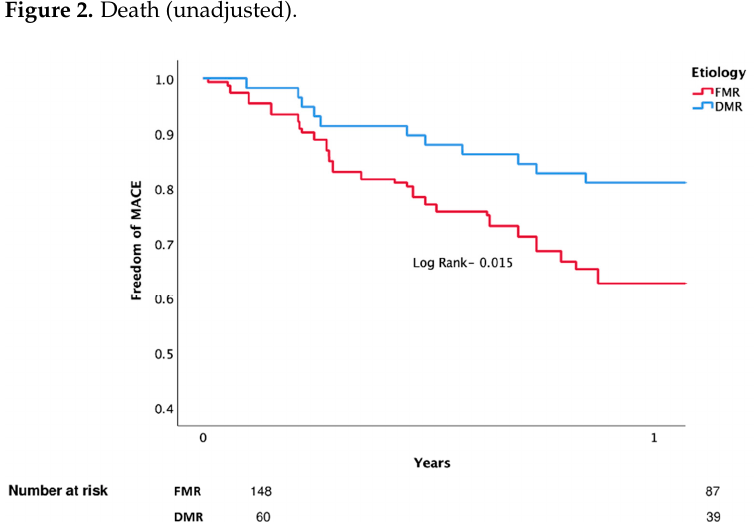
Figure 3. MACE (unadjusted).